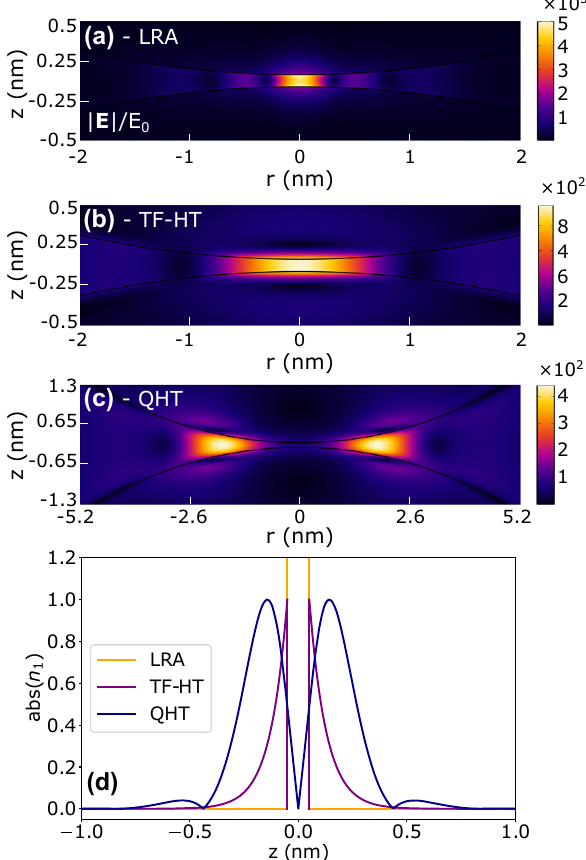
Figure 2: Norm of the total electric field (a–c) and the absolute value of the induced change density (d) as obtained from the LRA, TF and QHT at 𝜆 = 400 nm for g = 0 . 1 nm and R = 10 nm. The induced charge density is normalized to the maximum value in each